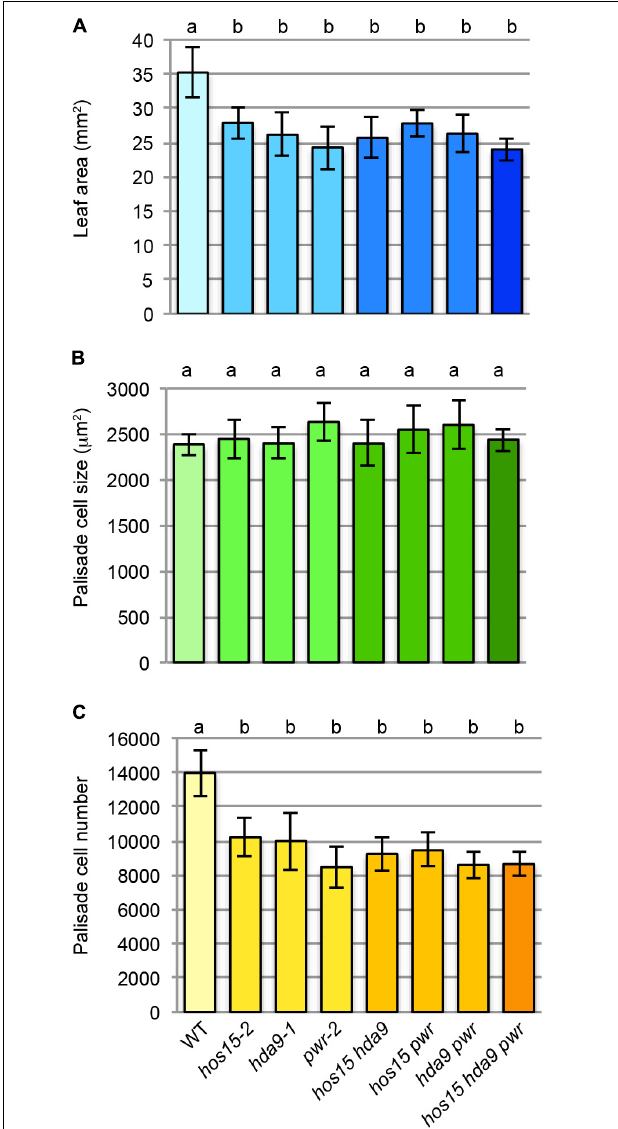
FIGURE 4 | Multiple mutant analyses among hos15-2 , hda9-1 , and pwr-2 . (A) Leaf area. (B) Palisade cell size. (C) Palisade cell number. The first leaves of 25-day-old leaves were used for the quantitative analyses ( n = 9–11). Statistical analyses were carried out by one-way ANOVA using the Tukey–Kramer post hoc test ( p < 0.01). Data without a significant difference are labeled by the same